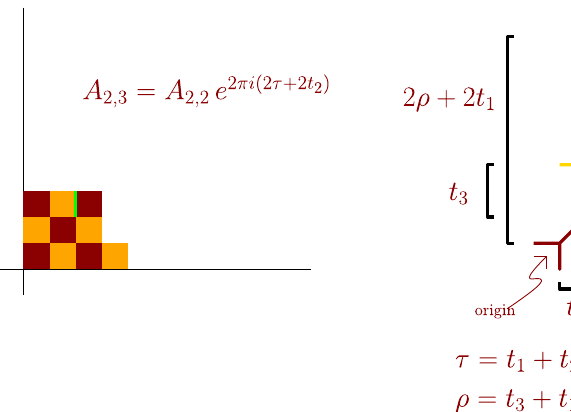
Fig. 3 Tessellation of Newton polygons and web diagram of